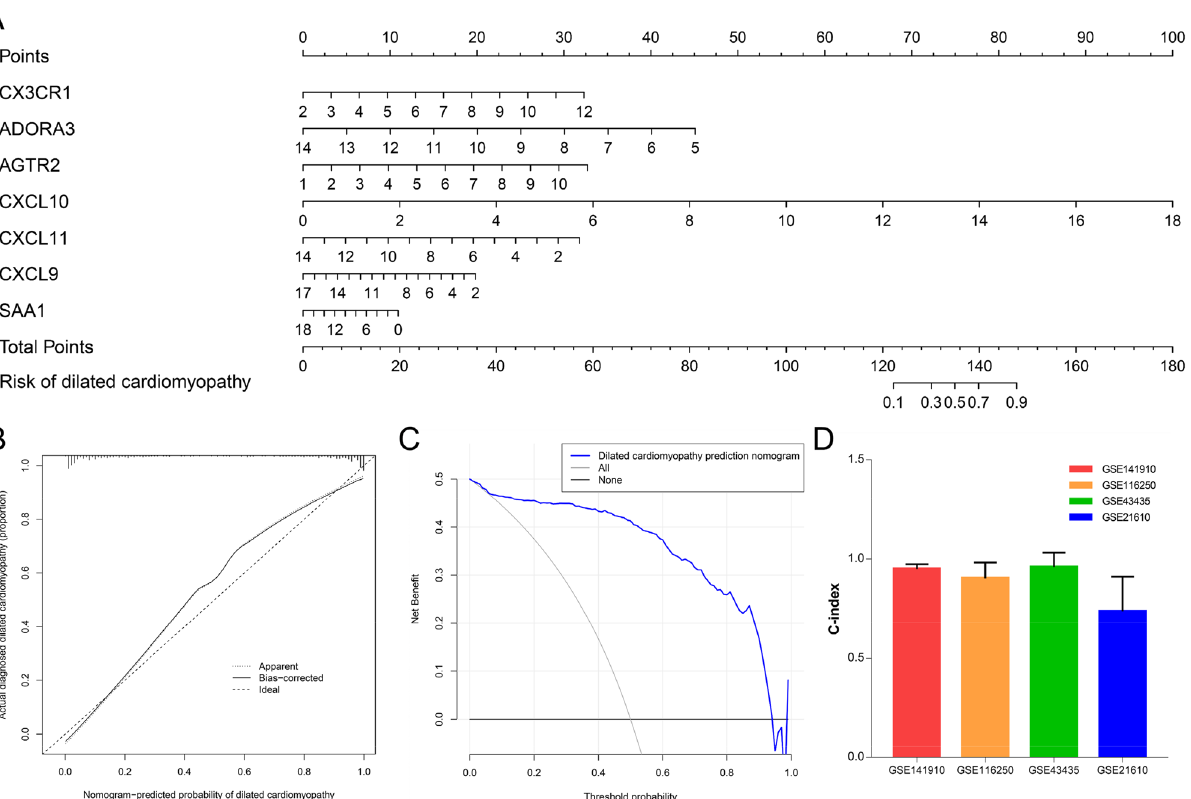
Figure 8. The establishment and verification of the diagnosis and prediction model of dilated cardiomyopathy. ( A ) 7 Predictive nomograms of genetic diagnosis. ( B ) Calibration curve. ( C ) Decision curve. ( D ) 4 C-index of external validation data